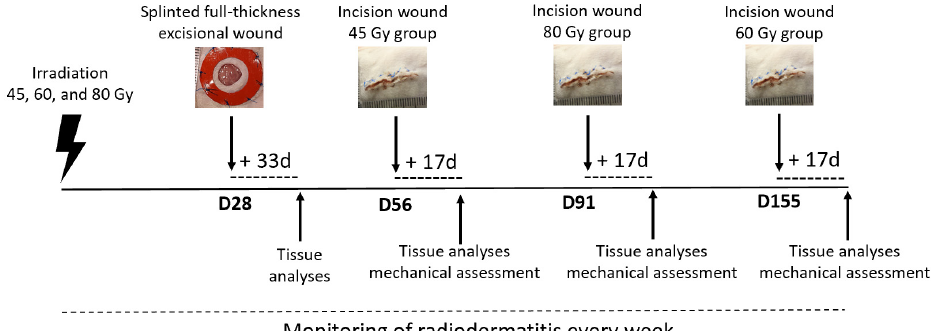
Figure 1. Schematic of the experimental design and timeline of the animal studies. Each week after irradiation, macroscopic images were taken to monitor radiodermatitis progression and resolution. For excisional surgery experiments, two full-thickness excisional wounds were created on the back of CD-1 mice on day 28 after irradiation. Healing was followed visually, and the scar tissues were harvested and processed 33 days later. For the incisional wound study, incisions were made as soon as the skin appeared macroscopically healed for each group, namely on day 56 for the group that received 45 Gy, day 91 for the 80 Gy group, and on day 155 for the group that received 60 Gy (for each time point, a control non-irradiated group was also included). The scar tissues were harvested 17 days after the incisions were made and characterized using mechanical assays.